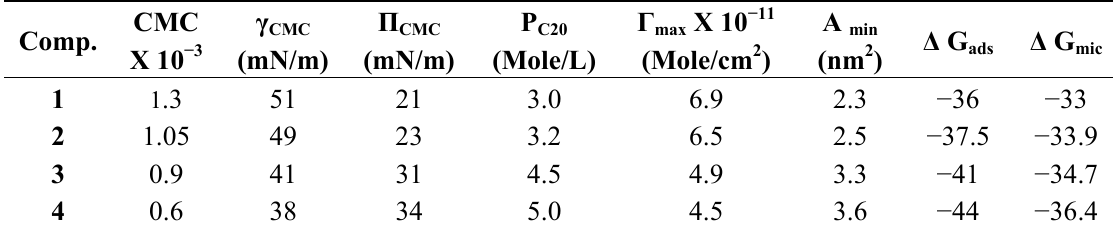
Table 1. The critical micelle concentration (CMC) and surface parameters of the tested compounds